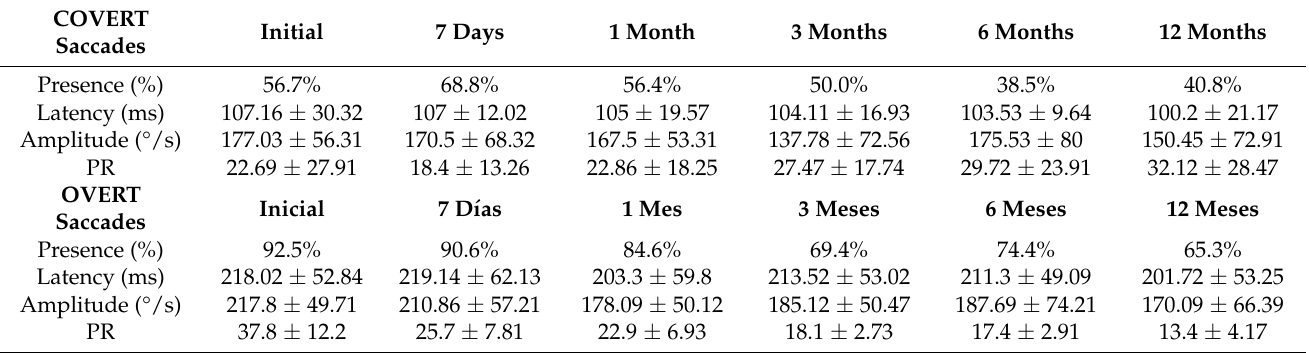
Table 4. Mean data for presence, latency, amplitude, and PR for both covert and overt saccades during the different follow-up periods.